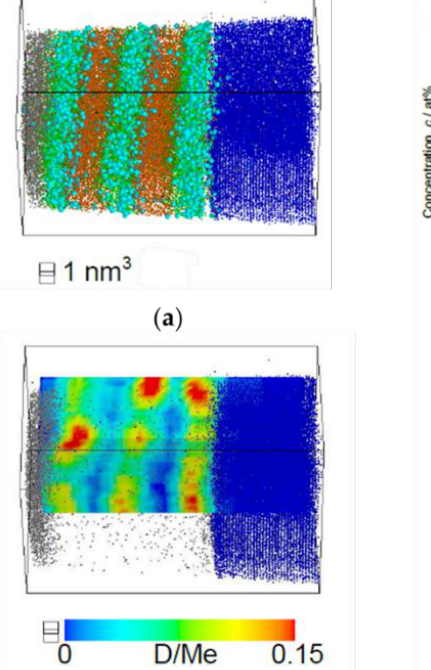
Figure 11. Reconstructed volume of Fe/V multi-layer (12 nm × 12 nm × 23 nm), loaded with D 2 10 Pa, analyzed at 30 K. ( a ) The whole volume of reconstruction (grey: Pd, green: V, orange: Fe, blue: W, light blue: D). ( b ) Iso-concentration map of D concentration ( c D = 0.22 D/Me) from the same re- construction in ( a ). ( c ) Depth concentration profile from 5 nm ϕ cylinder volume. The c D in the 3rd V is higher than in the other 2 V layers.